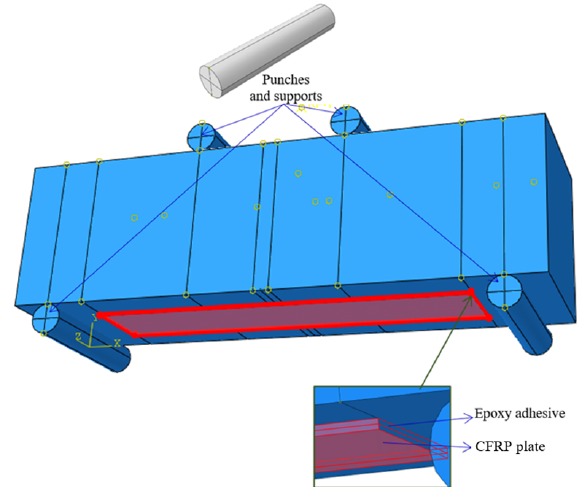
Fig. 4. Assembly of all parts of externally bonded CFRP plate on the concrete beam surface developed in the current